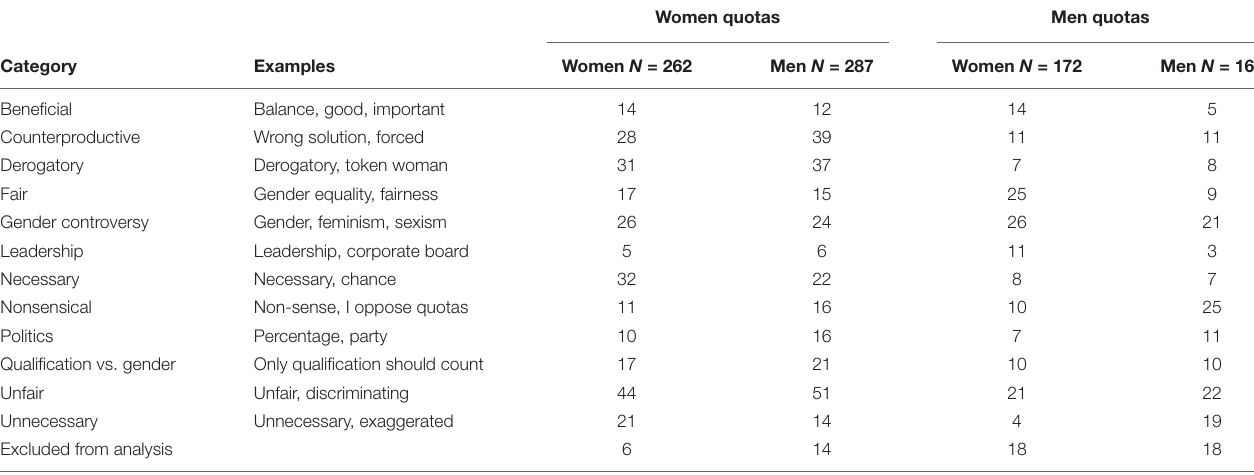
TABLE 5 | Absolute frequencies of free verbal associations assigned to the categories by quota and